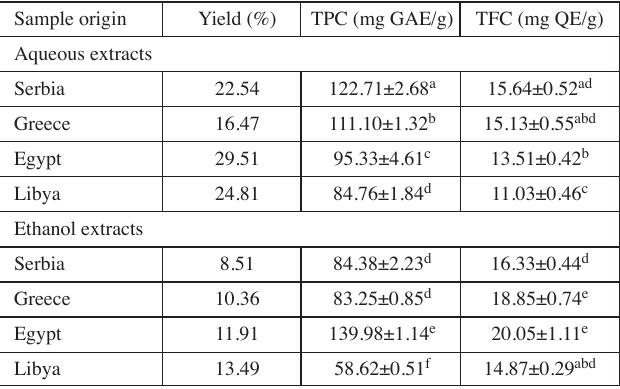
Tab. 1: Yields, total phenolic and flavonoid content of O. majorana extracts Sample origin